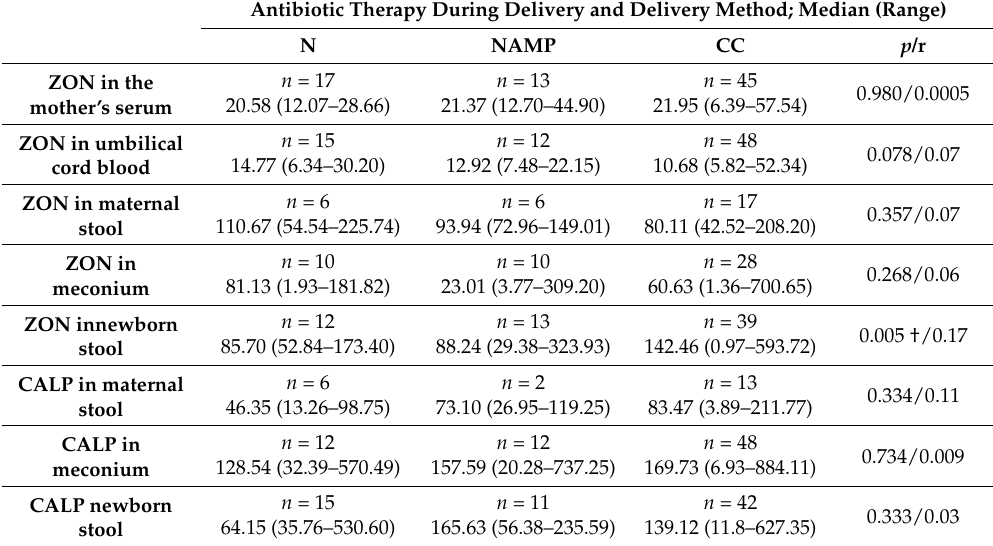
Table 7. Effects of antibiotic therapy on zonulin (ZON, ng/mL) and calprotectin (CALP, µ g/mL) concentrations. Antibiotic Therapy During Delivery and Delivery Method; Median